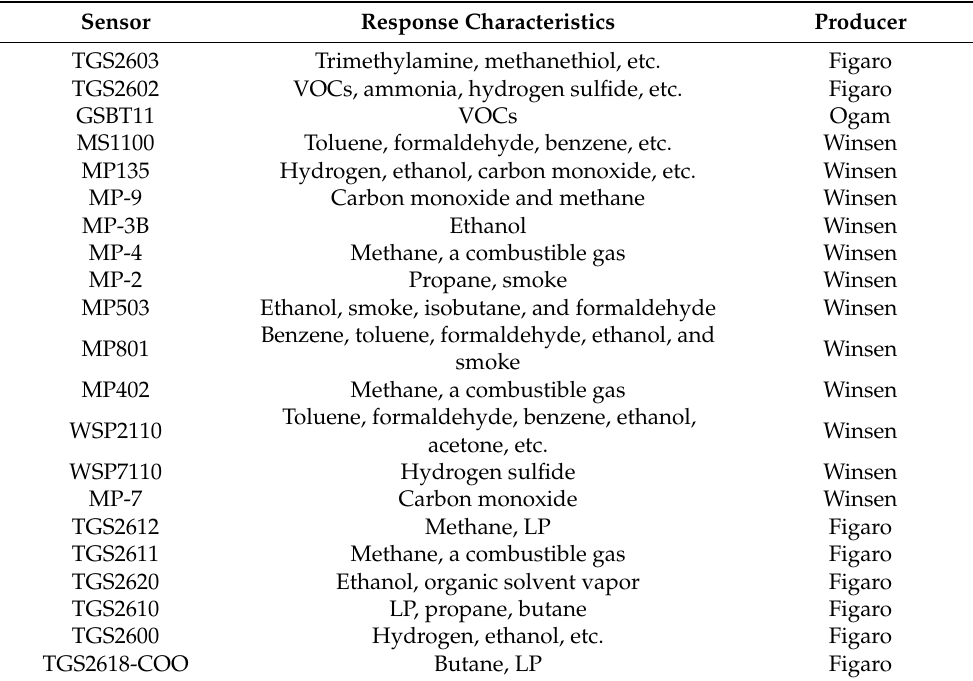
Table 1. sensor models, detection gas species, and companies.